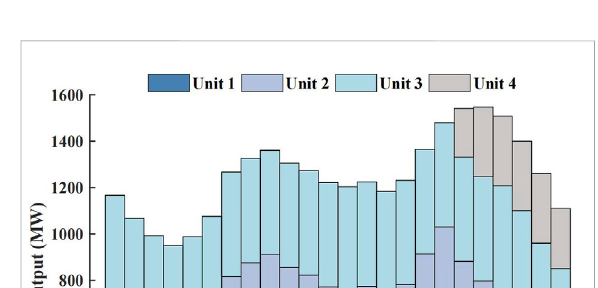
FIGURE 5 System load and clearing electricity price.